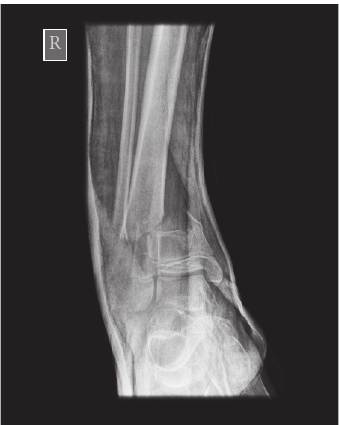
Figure 1: Case one: anteroposterior view of the ankle on admission to the emergency room indicating a tibiofibula transposition.